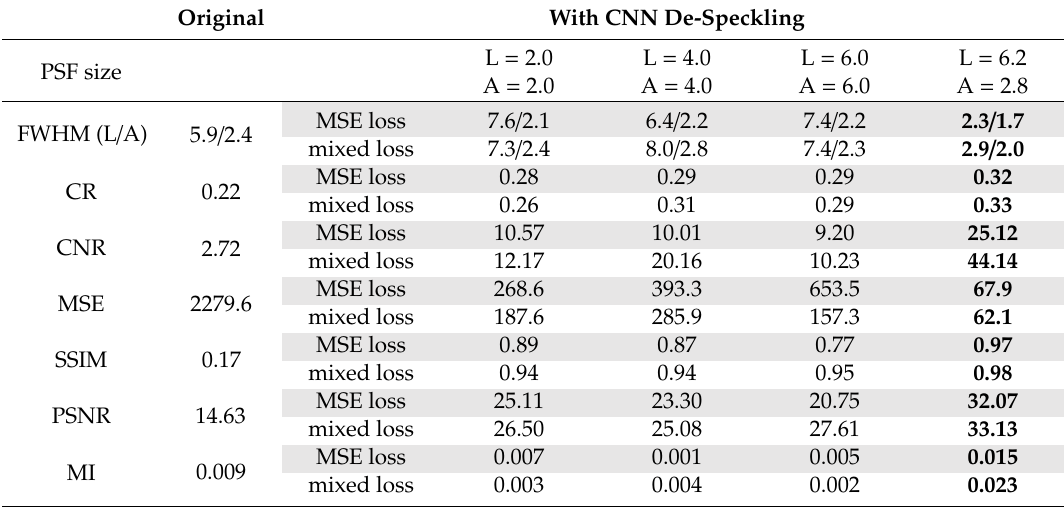
Table 3. Quantitative analysis of di ff erent size of PSF.